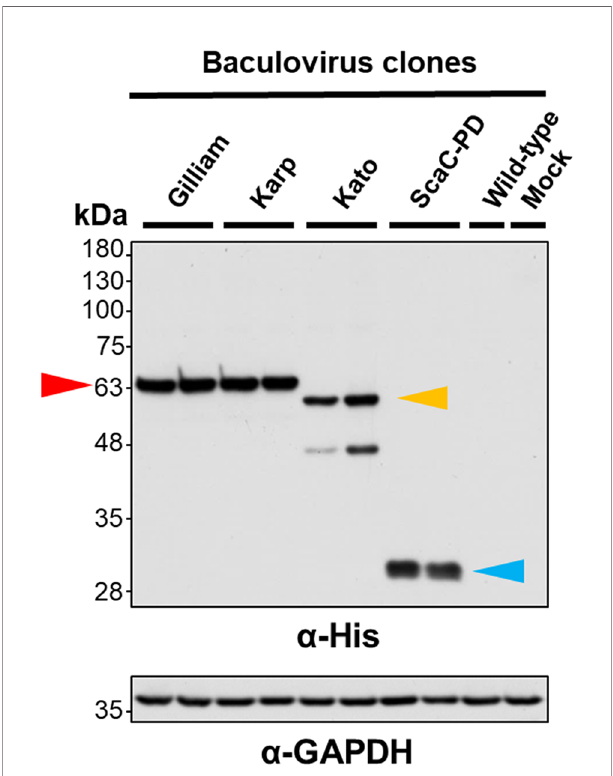
FIGURE 3 | Validation of recombinant protein expression by Western blot analysis. Sf21 cells were infected with recombinant baculoviruses expressing TSA56 or ScaC-PD for 2 days. Expression of target proteins was assessed by Western blotting using anti-His antibody. GAPDH expression was determined as a loading control using anti-GAPDH antibody. Red arrow: TSA56 protein of the Gilliam and Karp strains. Yellow arrow: TSA56 protein of the Kato strain. Blue arrow: ScaC-PD. Wild-type: cells infected with wild-type baculovirus lacking foreign gene expression. Mock: cells not subjected to virus